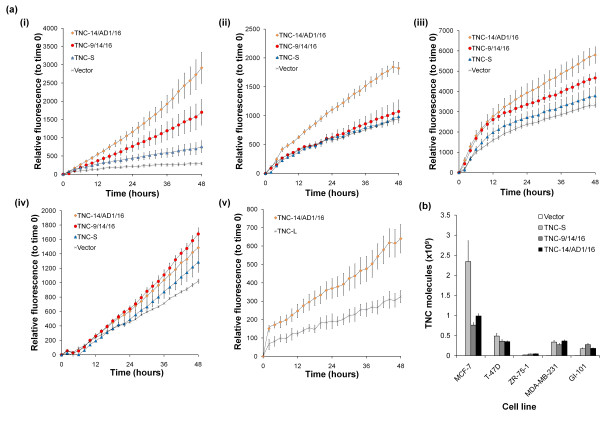
Direct effects of tenascin-C isoform expression on tumour cell invasion. (a) Monitoring tumour cell invasion in real time using a modified Boyden chamber assay in (i) MCF-7, (ii) T-47 D, (iii) MDA-MB-231 and (iv) GI-101 cell lines transfected with three different TNC isoform constructs and the vector control; and (v) invasion of MCF-7 cells transfected with TNC-L and TNC-14/AD1/16 constructs. In all cases, data points represent the mean of six replicates representing three separate transfections; error bars shown. (b) Quantitative RT-PCR of total TNC transcripts (exons 17/18) from cells transfected with TNC constructs.